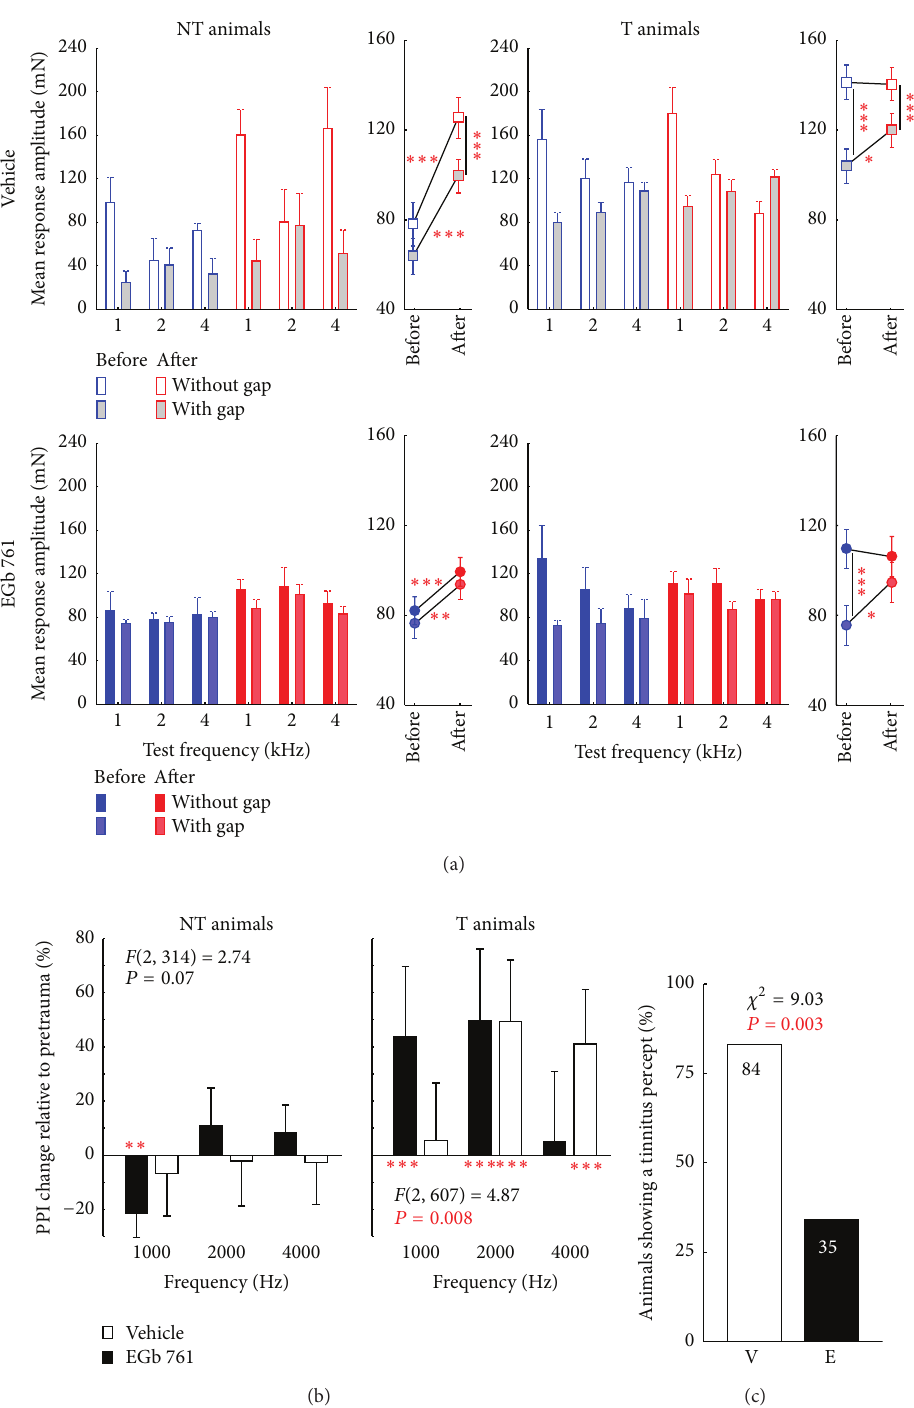
Figure 5: Development of tinnitus percept after acoustic trauma at 2kHz. (a) Mean startle amplitudes in mN (+95% confidence interval) for no-gap (open and solid symbols) and gap condition (gray and shaded filled symbols) of all animals separated by tinnitus development, treatment, and test frequency. 2-factorial ANOVA (only interaction shown) depict the changes in no-gap and gap conditions before and after trauma. Note that even when gap-effects are small on the group level they were always significant in the single animals before trauma. Asterisks indicate significance levels of post hoc Tukey tests: ∗ 𝑃 < 0.05 , ∗∗ 𝑃 < 0.01 , ∗∗∗ 𝑃 < 0.001 . (b) Change of PPI relative to pretrauma data. Significant positive values of PPI change reflect an impaired PPI, indicating the development of a tinnitus percept. 2-factorial ANOVA indicates that EGb 761 treated animals develop tinnitus percepts at lower frequencies than vehicle treated controls. Asterisks below or above the abscissa indicate significant change of PPI ( 𝑡 -test versus 0): ∗∗ 𝑃 < 0.01 , ∗∗∗ 𝑃 < 0.001 . (c) Percentage of animals that develop a tinnitus percept after an acoustic trauma at 2kHz. EGb 761 treated animals show significantly less signs of a tinnitus percept (chi 2